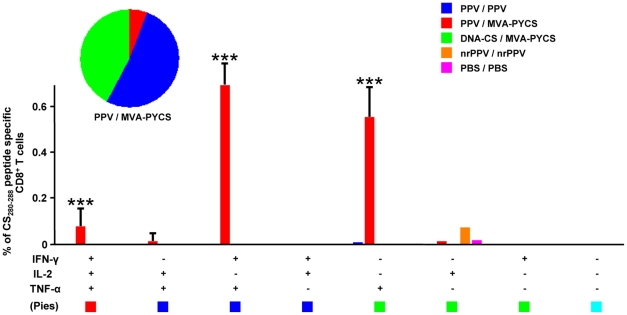
Polyfunctionality of CD8+ T-cells is improved by heterologous prime/boost.Groups of BALB/c mice (4 per group) were immunized in prime/boost as indicated in Table 1 and 53 days post boost splenocytes were processed for ICS as described under Materials and Methods. Memory CD8 T-cells were differentiated into single, double or triple positive cells secreting IFN-γ (PeCy7), TNF-α (PE) and IL-2 (APC). Polyfunctionality is indicated by the pie chart.The data was then analyzed using SPICE software. Data are expressed as mean ± s.e. (n = 4 mice per group). Statistical values were determined by a novel approach previously described (33). P values were calculated between PPV/MVA-PYCS and PPV/PPV groups. **p<0.01; ***p<0.001.